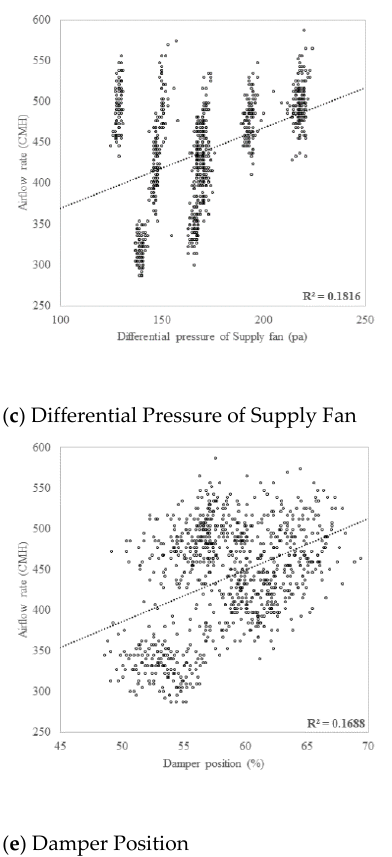
Figure 3. Scatter plot of air flow rate.